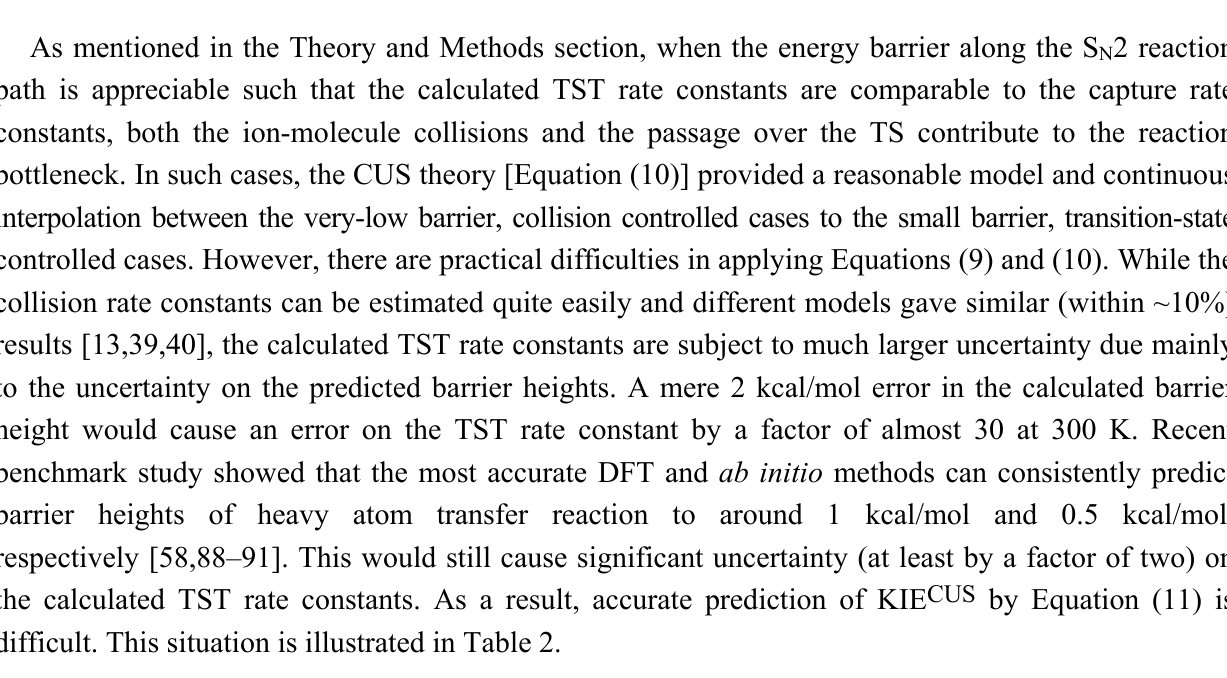
Table 2. Calculated reaction energetics (in kcal/mol), the experimental and theoretical rate constants (in cm 3 molecule − 1 s − 1 ), and KIEs of the F − (H the gas phase at various levels of